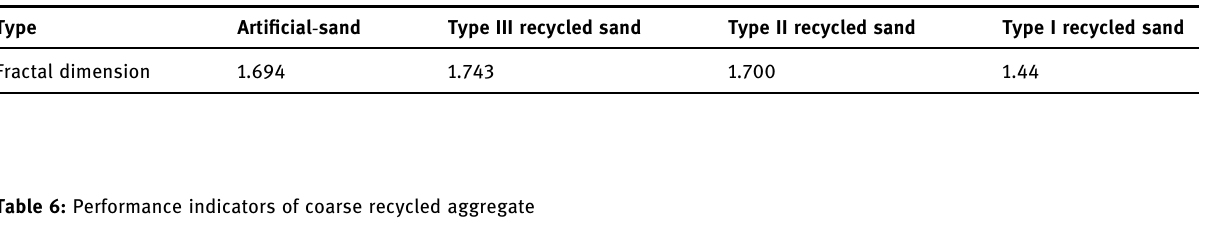
Table 5: Fractal dimension of sand outline in particle group state